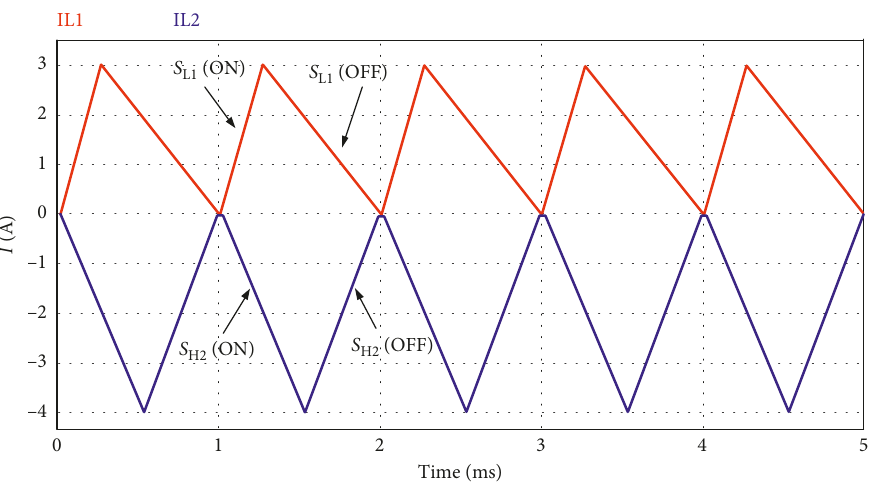
Figure 8: Current flow on inductor in HNFABC. Table 3: Simulation and experimental